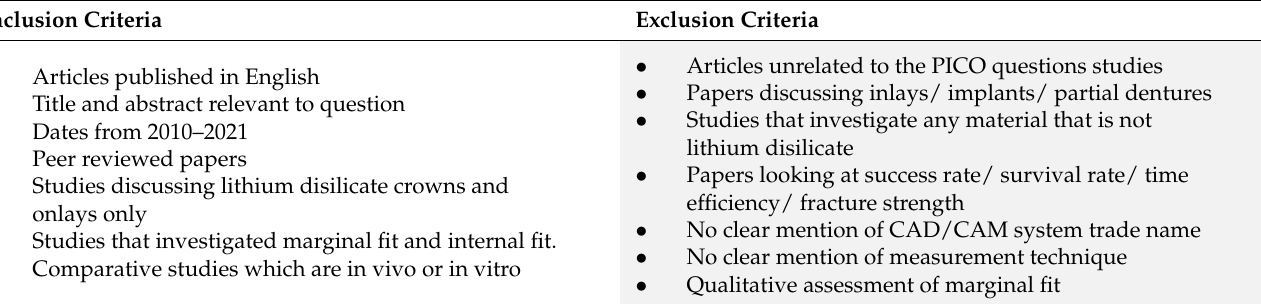
Table 1. Inclusion/Exclusion criteria for the literature